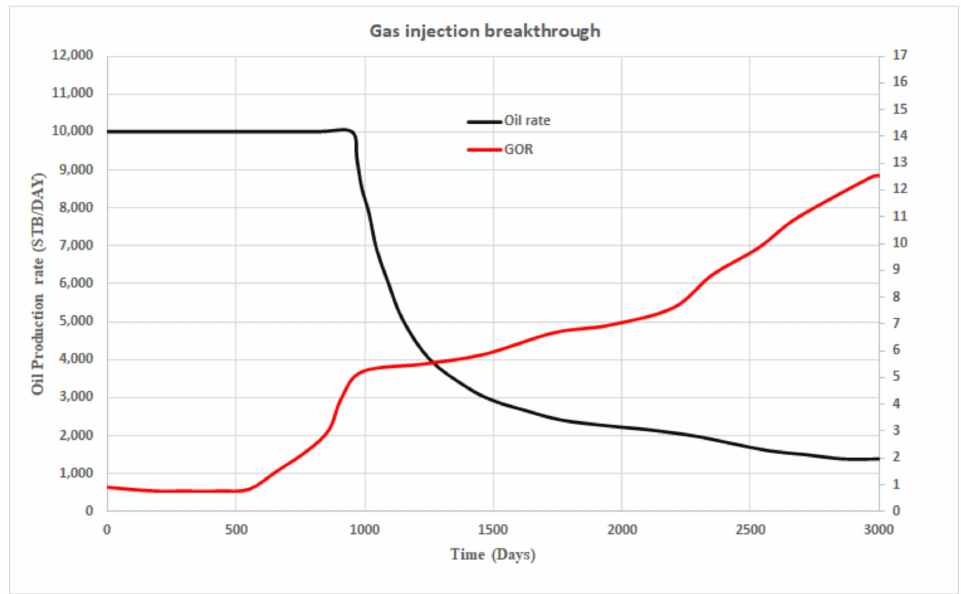
Figure 6. High GOR in gas injection due to early